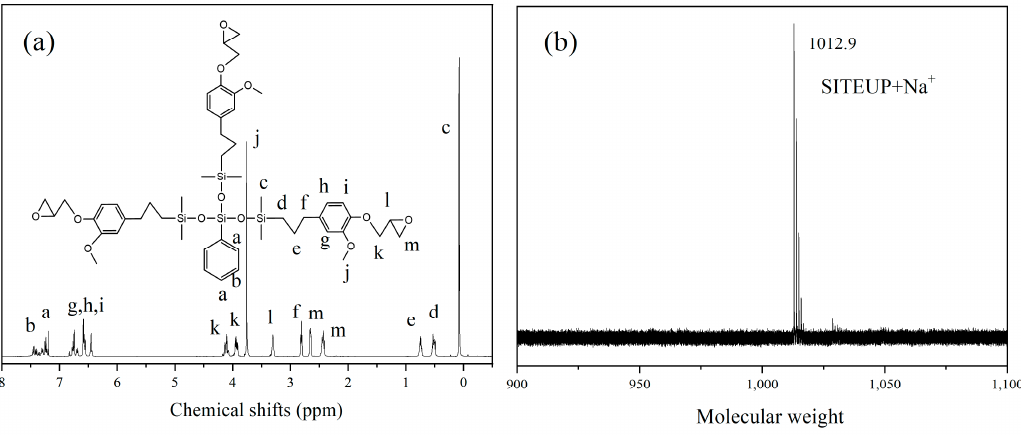
Figure 2. ( a ) 1 H-NMR and ( b ) MADLI-TOF-MS spectra of SITEUP.